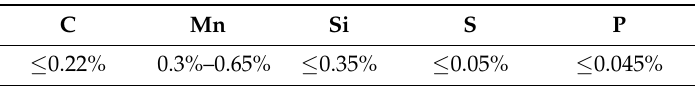
Table 1. Composition of Q235 carbon